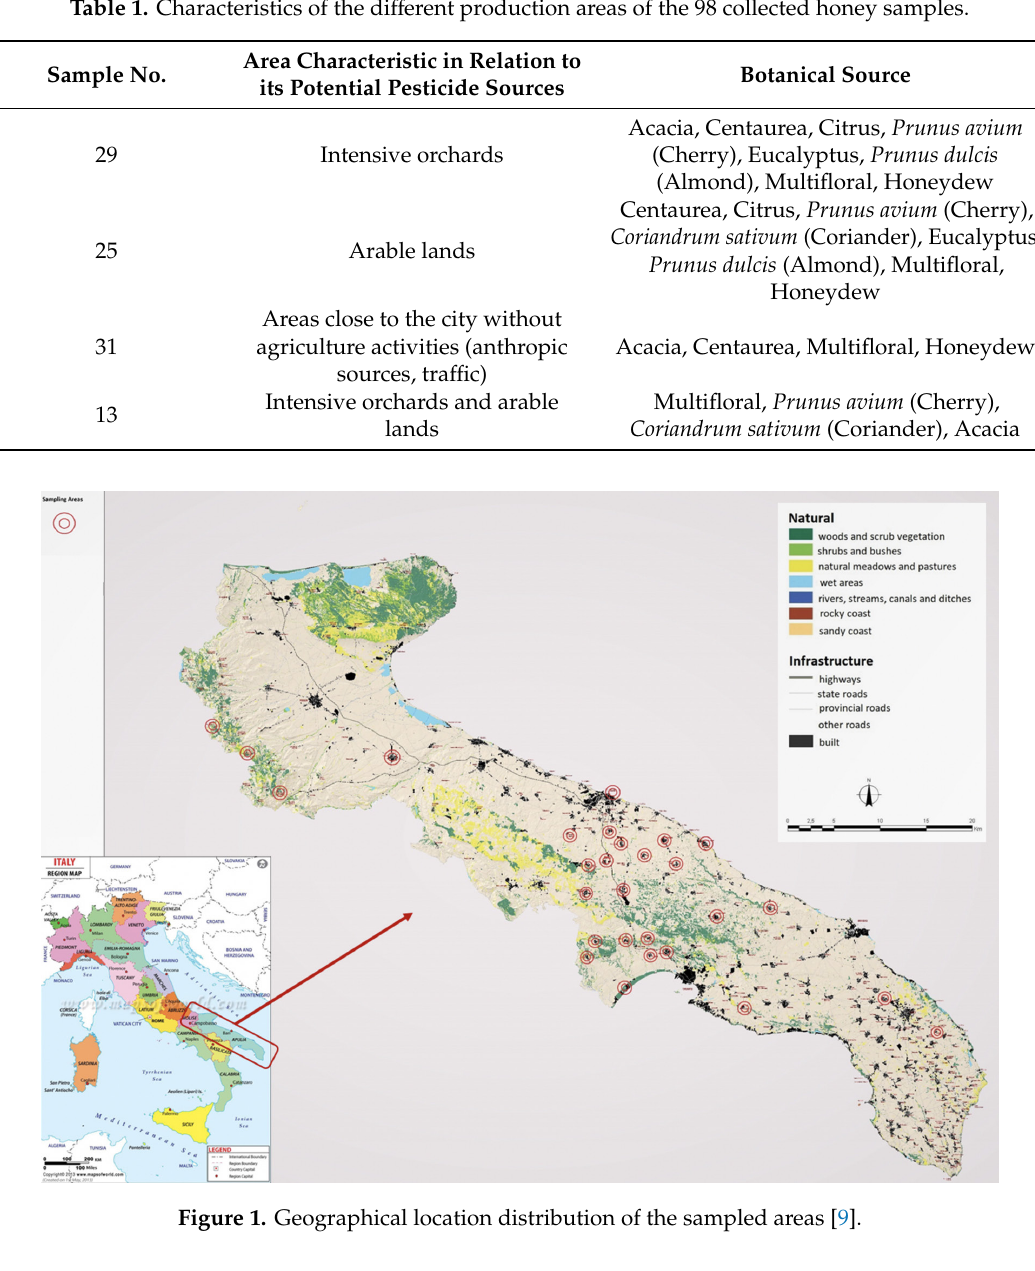
Figure 1. Geographical location distribution of the sampled areas [9].